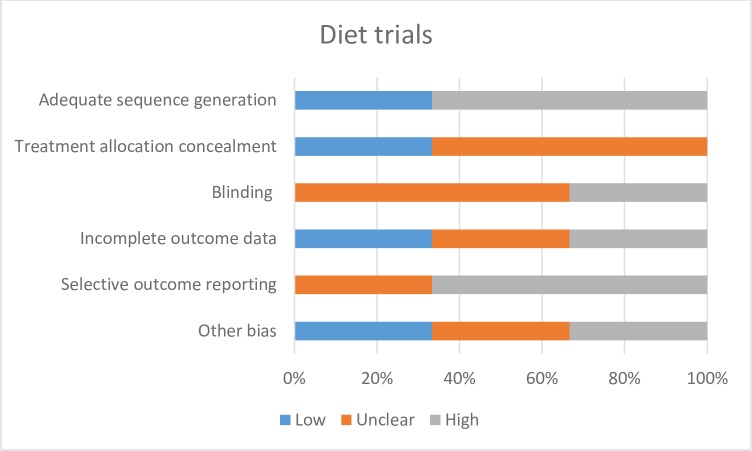
Risk of bias summary–diet.